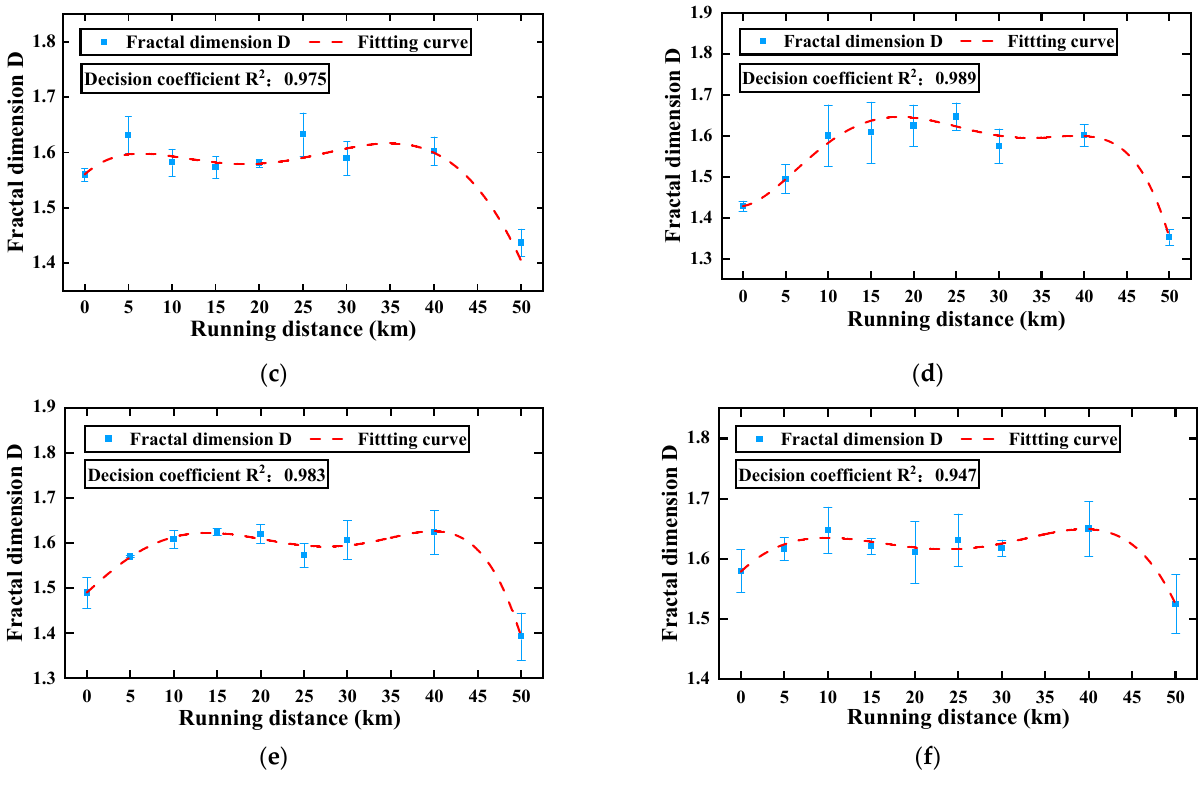
Figure 12. Evolution of the fractal dimension during wear. ( a ) Region 1, ( b ) Region 2, ( c ) Region 3, ( d ) Region 4, ( e ) Region 5, ( f ) Region 6.